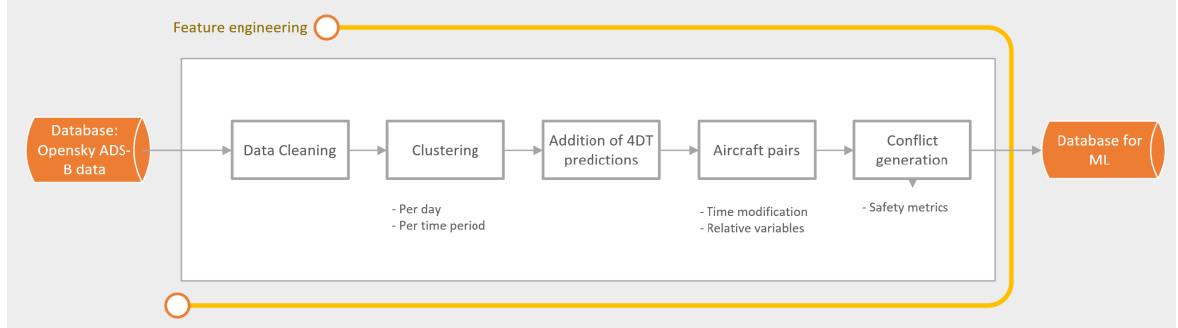
Figure 2. Flow of the feature engineering process. Weather or operational variables of airspace status were not considered, and should be included in further work.